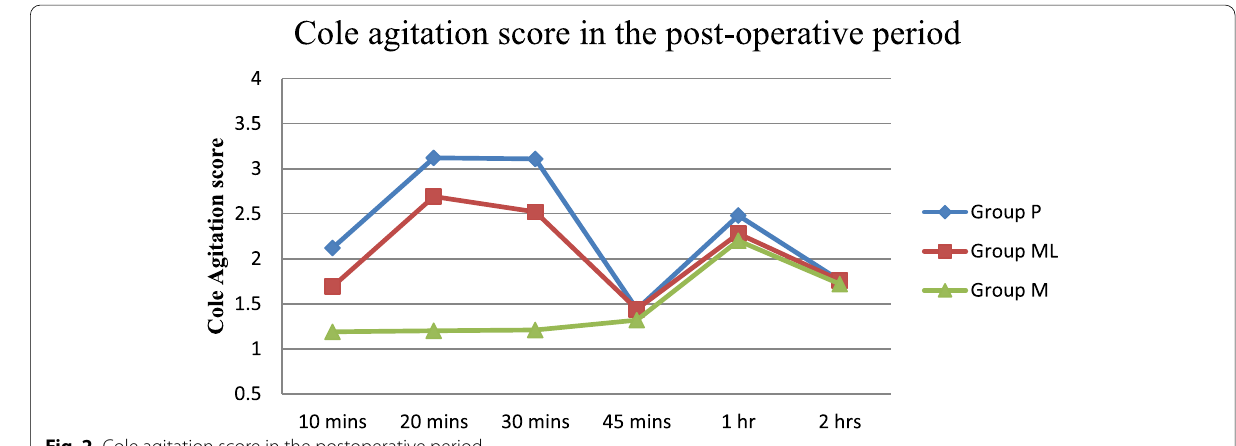
Fig. 2 Cole agitation score in the postoperative period